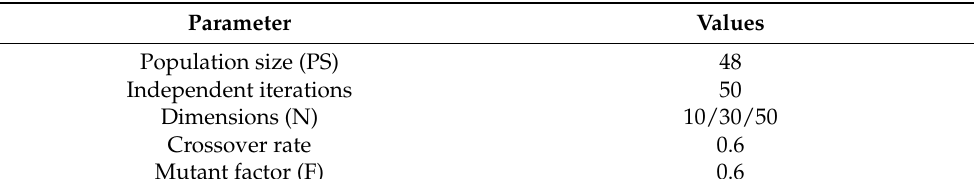
Table 6. Experimental settings of the proposed GA-FIS.